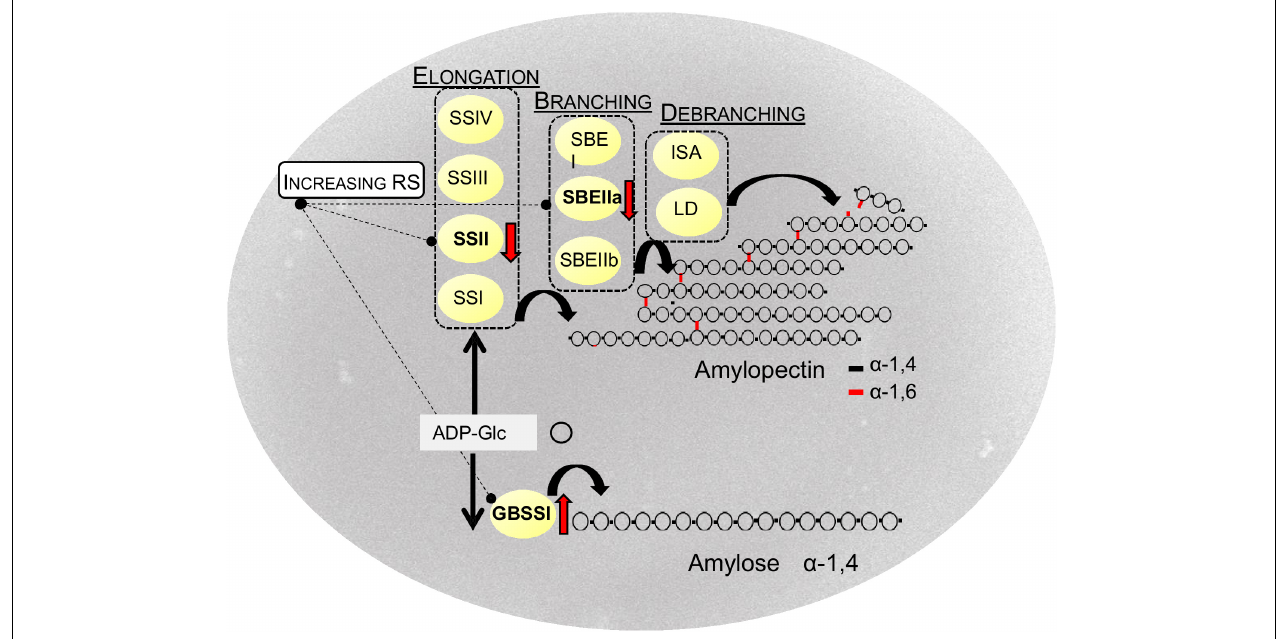
FIGURE 3 | Biosynthesis of (resistant) starch in cereals. SS, starch synthases; SBE, starch branching enzymes; ISA, isoamylases; LD, limit dextrinase. GBSSI Granule Bound Starch Synthase, ADP-Glc: ADP-glucose. Red arrows indicate the main targets to increase